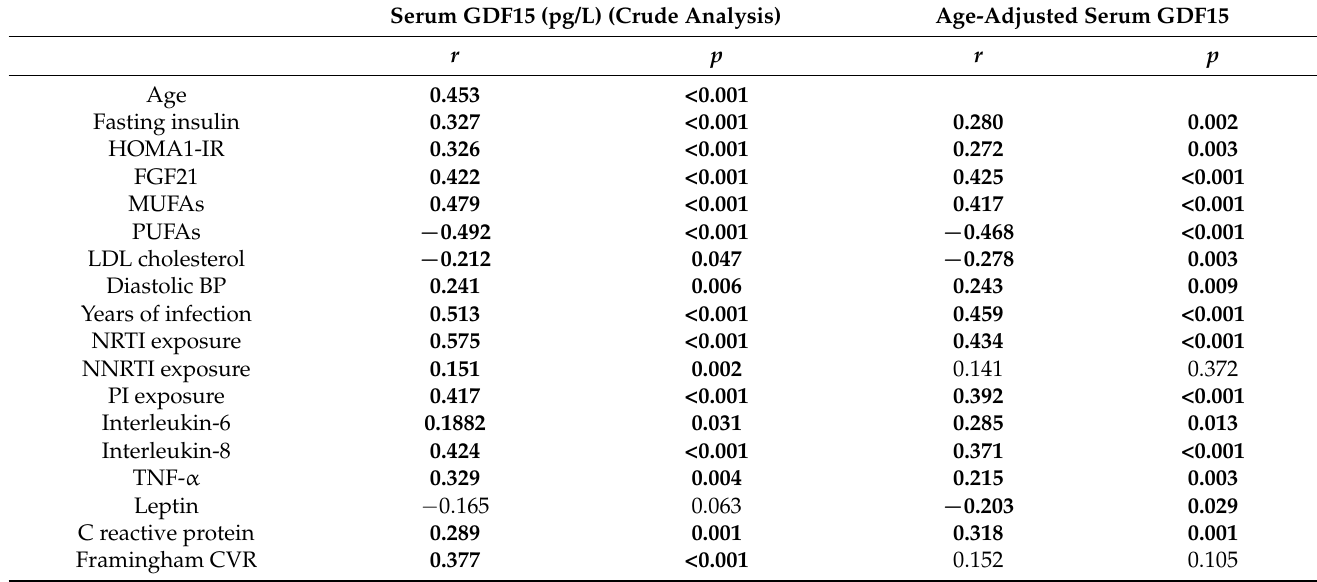
Table 3. Correlations of serum GDF15 levels with anthropometric, metabolic, infectious and treatment factors in PLWH.